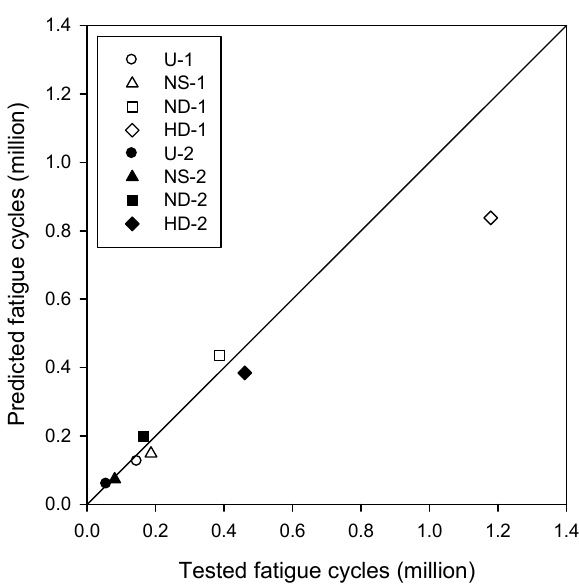
Figure 17. Fatigue life comparison between predicted results and experiential data.